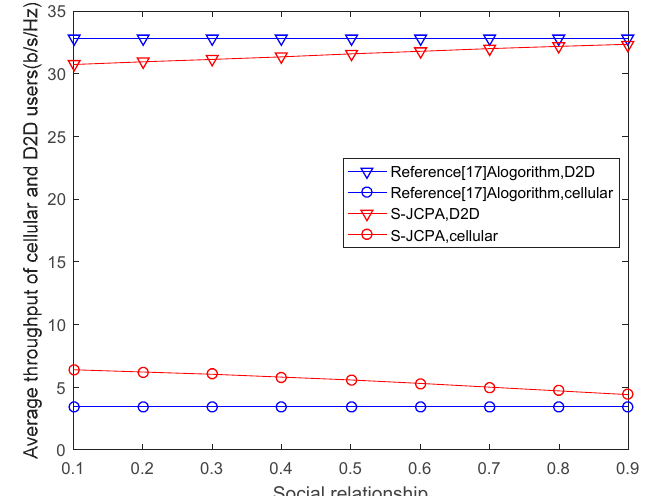
Figure 6. Average throughput of cellular and D2D users for different algorithms with different social relationships, M = 20, N = 5 .